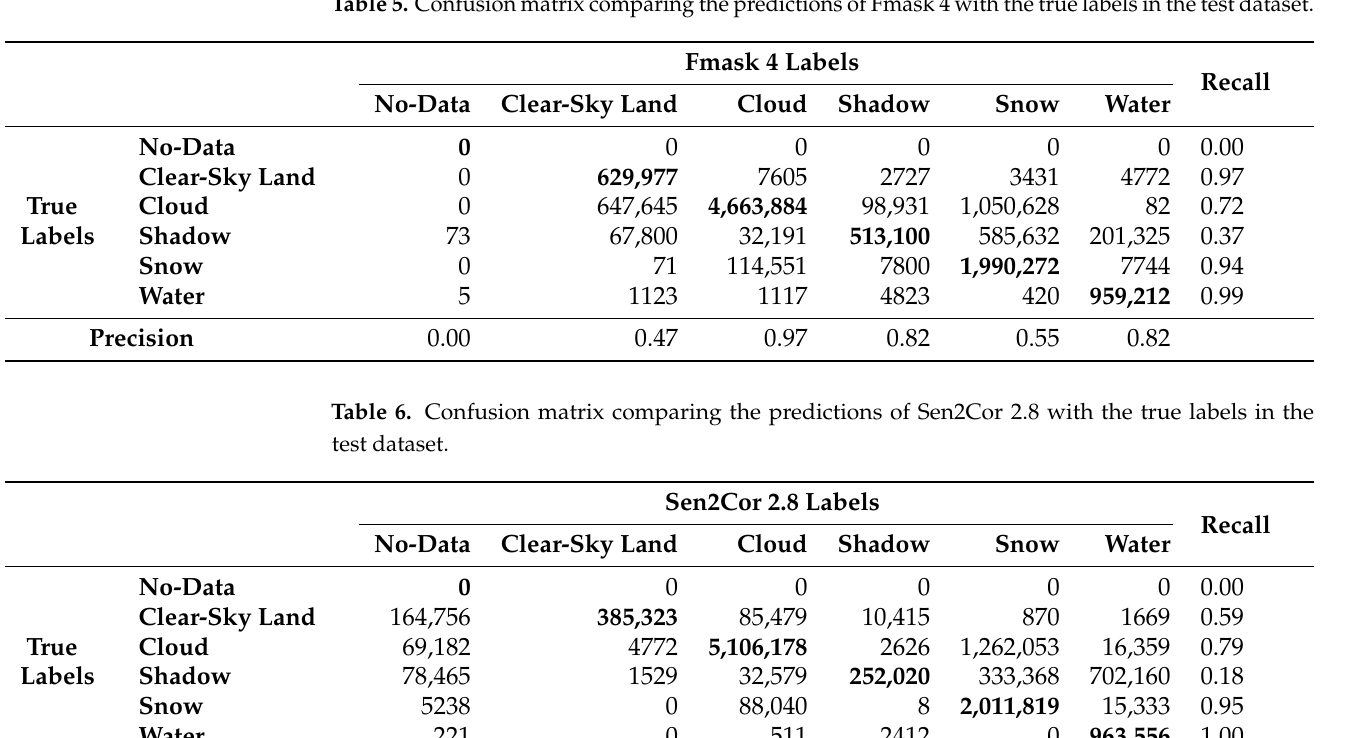
Table 5. Confusion matrix comparing the predictions of Fmask 4 with the true labels in the test dataset.